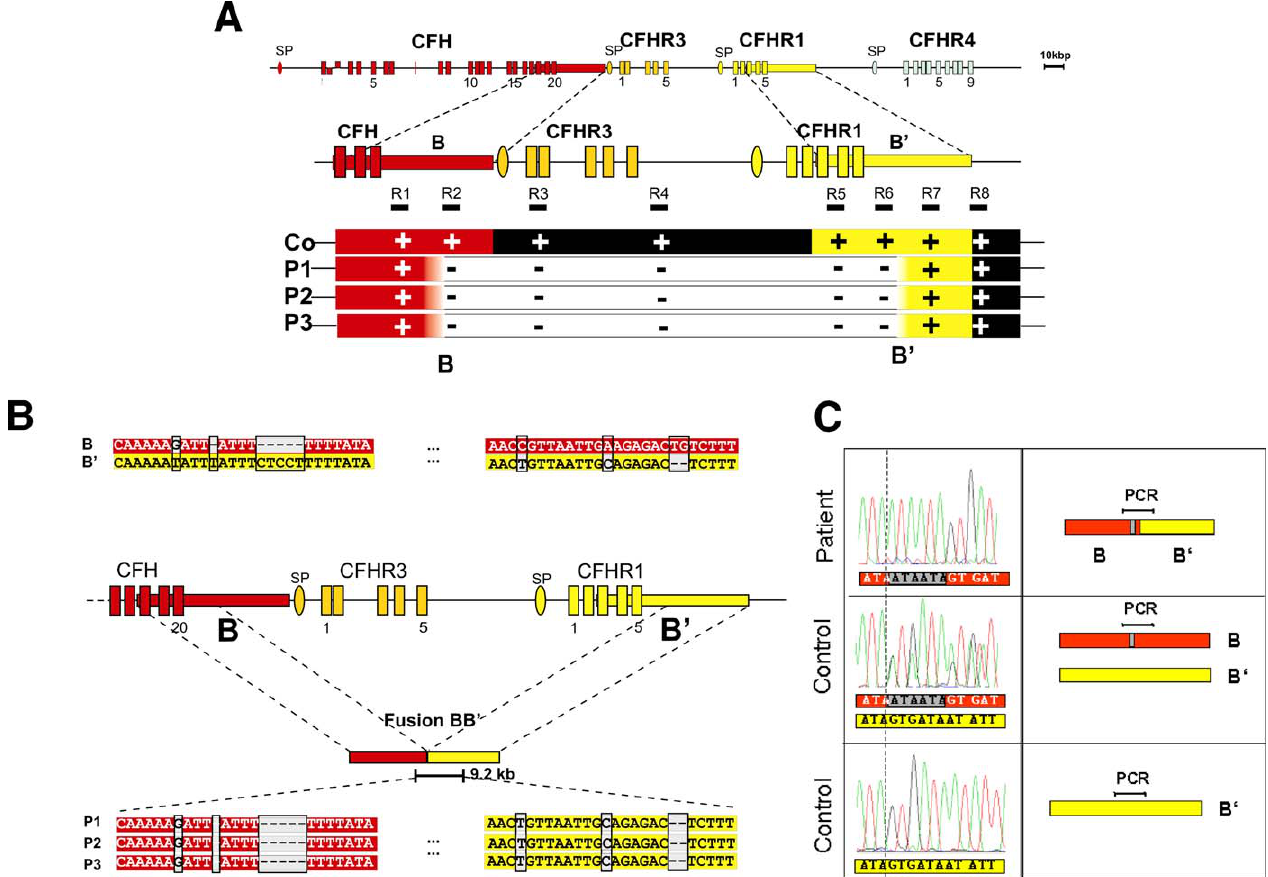
Figure 2. Map of the Human Factor H Gene Cluster (A) The 20 SCRs of CFH , the five SCRs of CFHR3 , the fiveSCRs of CFHR1, and the nine SCRs of CFHR4 are indicated by vertical bars. The position of the two duplicated homologous segments (B and B 9 ) and that of the eight primer pairs (R1–R8) is shown. Failure ( (cid:2) ) to amplify DNA downstream of CFH in the three HUS patients reveals a deletion of a genomic ; 84-kb fragment. (B) Sequence comparison of segment B (red) and segment B 9 (yellow) reveals blocks with sequence diversity. Fusion of the homologous segments and localization of the breakpoints in three CFHR1/CFHR3 deficient HUS patients are indicated . Fusion of segments B and B 9 is demonstrated by amplification of a 9.2-kb PCR fragment using a forward primer specific for segment B and a reverse primer specific for segment B 9 . For all three patients, sequences of block 1 are derived from segment B (red) and sequences of block 2 are derived from segment B 9 (yellow). (C) Similar PCR products were generated with primers common for segment B and segment B 9 . Amplification of both segments is confirmed by sequence analysis. Sequence of PCR products from the patient is identical to segment B of a control DNA (upper panel). Sequence of PCR products of a control person is identical to segment B and B 9 (middle panel). Identification of sequence B 9 of the control person (lower panel). Sequence differences between segment B and segment B 9 are indicated (grey bar).